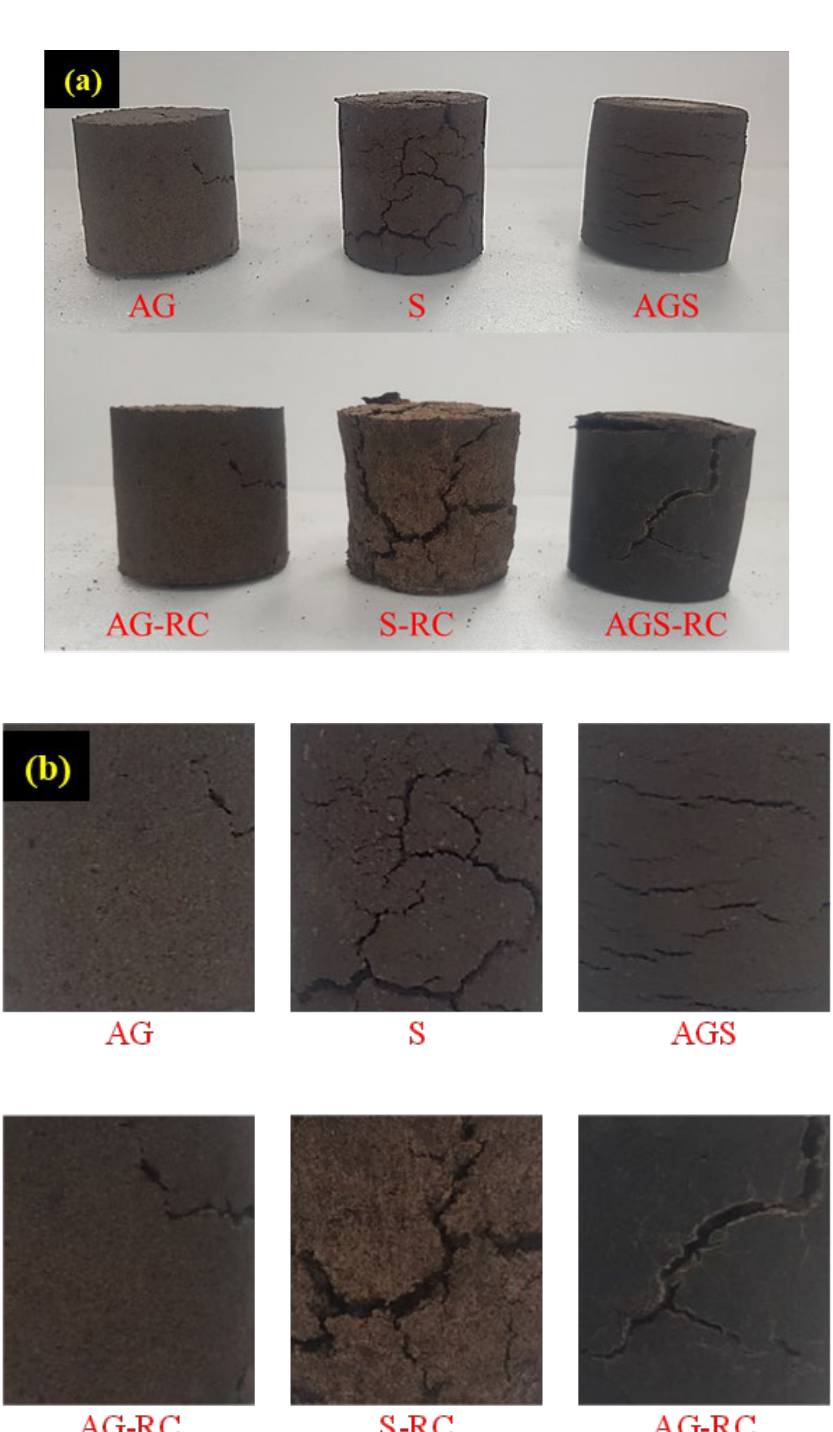
Figure 4. The photo of the cured samples ( a ) and surface of the each sample ( b ). Table 4. Test results of all samples.